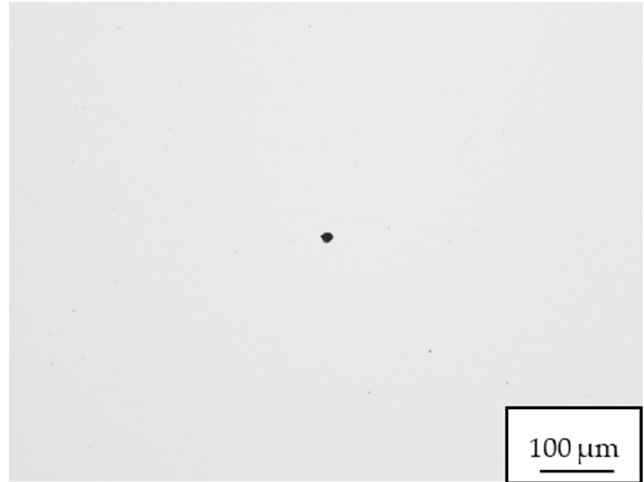
Figure 11. Oxidic inclusions at the edge of steel plate (sample